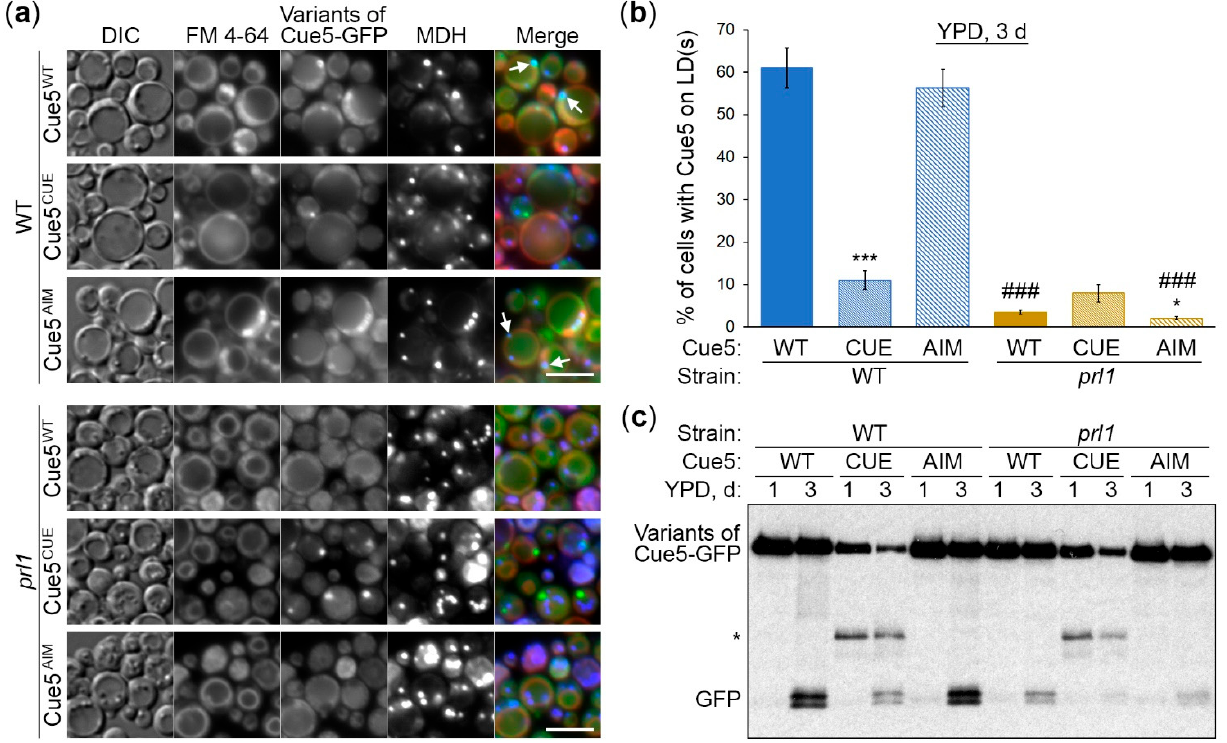
Figure 4. Cue5 accumulation on LDs and degradation by S-phase lipophagy depend on Prl1. ( a ) Localization of Cue5-GFP variants. The cells of WT and prl1 strains expressing different variants of Cue5-GFP were grown for 3 d in YPD medium with FM 4-64 (vacuolar membrane, red) and MDH (the last 2 d, LDs, blue). ↑ : Representative LDs with Cue5-GFP. Scale bar, 5 µm. ( b ) Quantification of images in ( a ). Displayed are the averages and standard errors. * and ***: p ≤ 0.05 and p ≤ 0.001, for mutant Cue5-GFP versus WT Cue5-GFP in the same strain; ###: p ≤ 0.001, prl1 versus WT for the same Cue5-GFP variant. ( c ) Processing of the Cue5-GFP variants to GFP. The cells of WT and prl1 strains expressing different variants of Cue5-GFP were grown in YPD medium and equal biomass was taken at time-points 1 d and 3 d for testing S-phase lipoph- agy. Ponceau S staining (Figure S3) was used as a loading control. *: Intermediate GFP-fusion